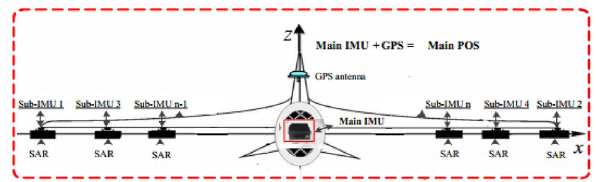
Figure 1. DPOS installation